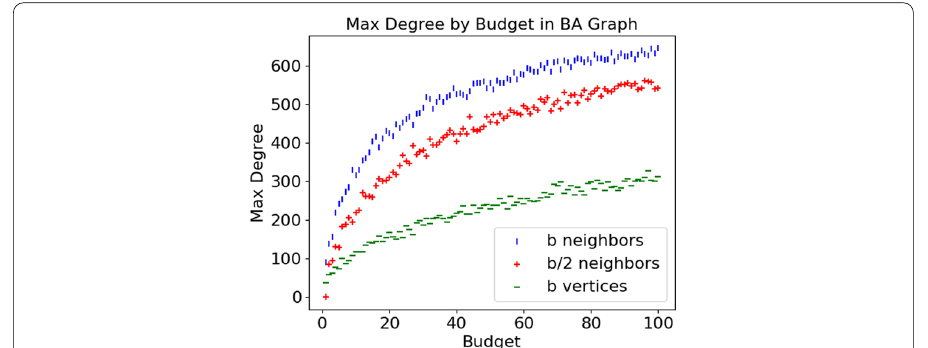
Fig. 1 Max‑degree in a collection of selections in BA graphs for a budget b of how many vertices to